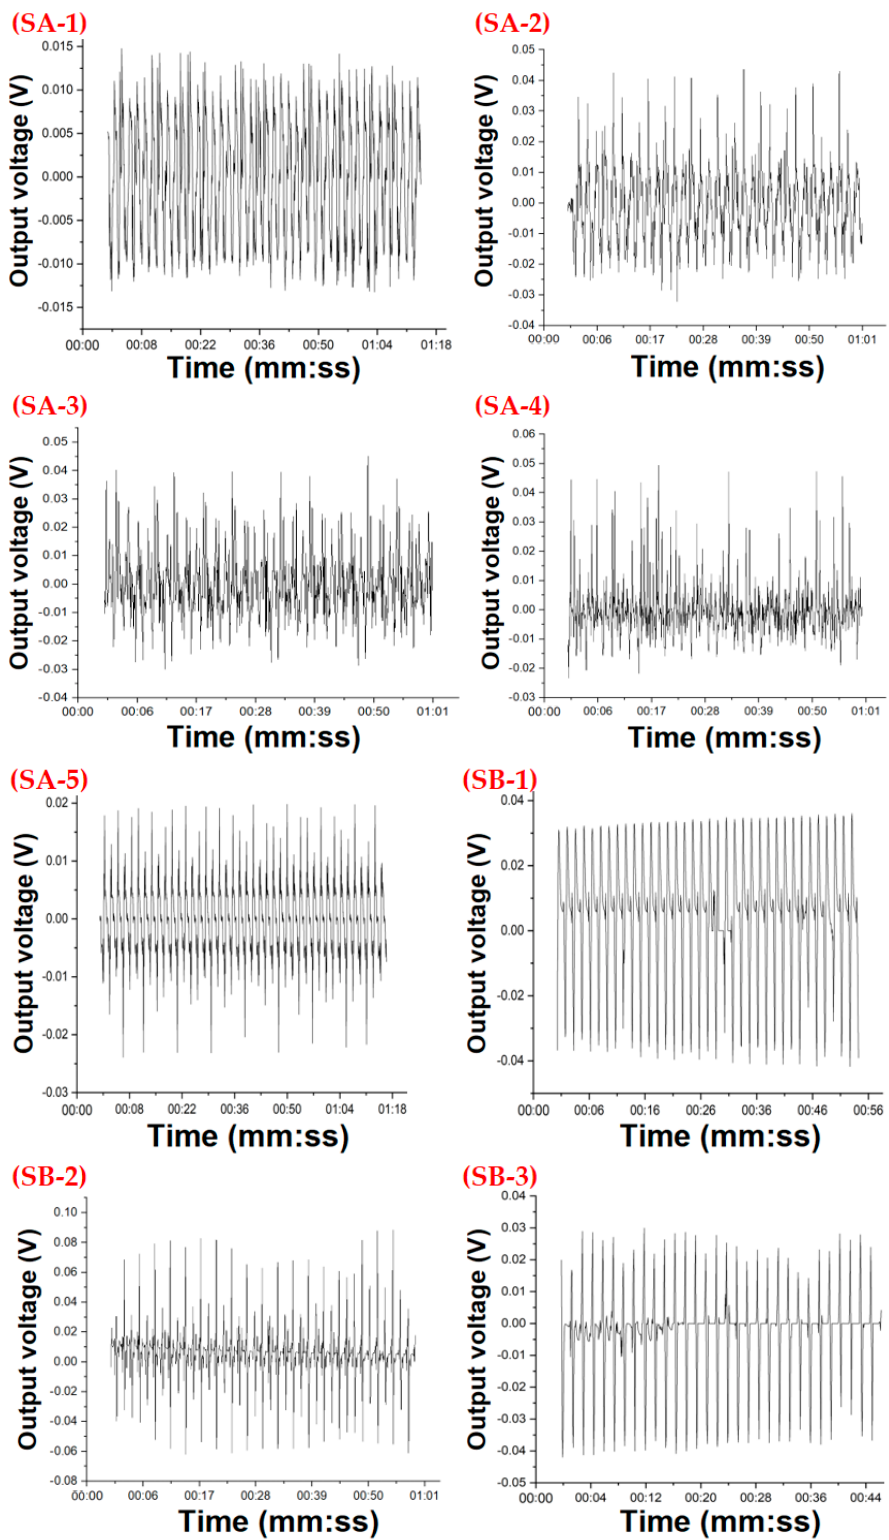
Figure 7. The raw output voltage graphs that were used to extract the mean peak-to-peak voltages compared in Figure 6 for the eight samples of the Ag / ZnO / Cr / ITO structure that were annealed